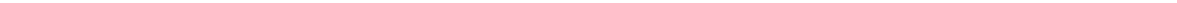
Fig. 8 Role of PPAR α and ChREBP β in lipolysis and lipogenesis in WAT and in adipocytes. a Western blot analysis and quanti fi cation of ATGL in IngWAT from fl oxed and H3atKO mice fed LFD or HFD ( n = 2, where each replicate represent a pool of samples from 3 mice); b , c mRNA expression of Ppara and Pdk4 in IngWAT from fl oxed and H3atKO mice fed LFD or HFD ( n = 9 – 11 for LFD mice, n = 5 per group for HFD samples); d Western blot and quanti fi cation of pSer-293 PDHE1 α , pSer-300 PDHE1 α , PDHE1 α in IngWAT of Hdac3 fl oxed and knock out mice fed LFD or HFD ( n = 2, where each replicate represent a pool of samples from 3 mice); Data are presented as mean ± s.e.m. Statistical analysis: two way ANOVA, Tukey as post hoc test, * p < 0.05, ** p < 0.01, *** p < 0.001 vs. Floxed LFD, # p < 0.05, ## p < 0.01, ### p < 0.001 vs. H3atKO LFD, § p < 0.05, §§ p < 0.01, §§§ p < 0.001 vs. Floxed HFD. e Western blot and quanti fi cation of pSer-293 PDHE1 α , pSer-300 PDHE1 α , PDHE1 α in cells infected with adenovirus expressing shRNA targeted to Hdac3 or to a